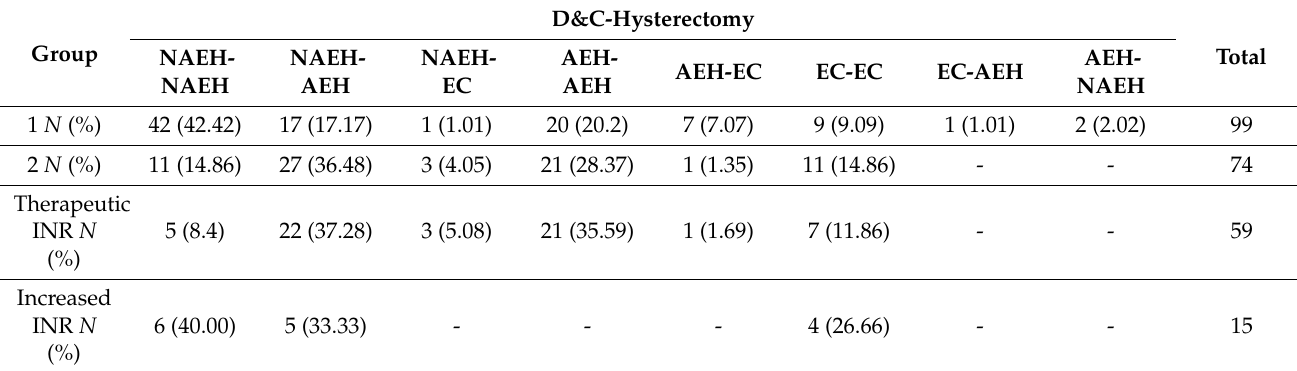
Group 1—patients without oral anticoagulant treatment, Group 2—patients with oral anticoagulant treatment, N = number, NAEH = non- atypical endometrial hyperplasia, AEH = cellular atypia endometrial hyperplasia, EC = endometrial cancer, D&C = dilation and curettage, INR = International Normalized